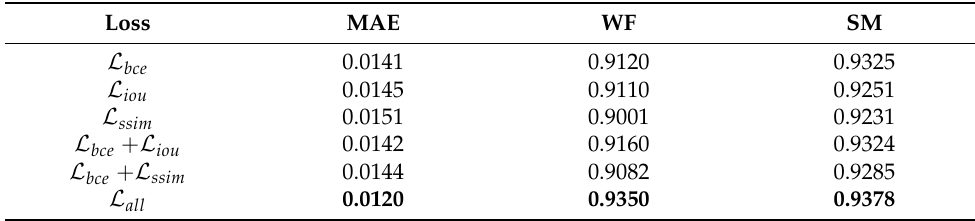
Figure 8. Visualization of the results of different losses. ( a ) Strip steel surface images; ( b ) ground truth; ( c ) L bce ; ( d ) L iou ; ( e ) L ssim ; ( f ) L bce + L ssim ; ( g ) L bce + L iou ; and ( h ) L all (ours). Red boxes indicate areas where defects are incomplete. Table 2. The results of different losses.